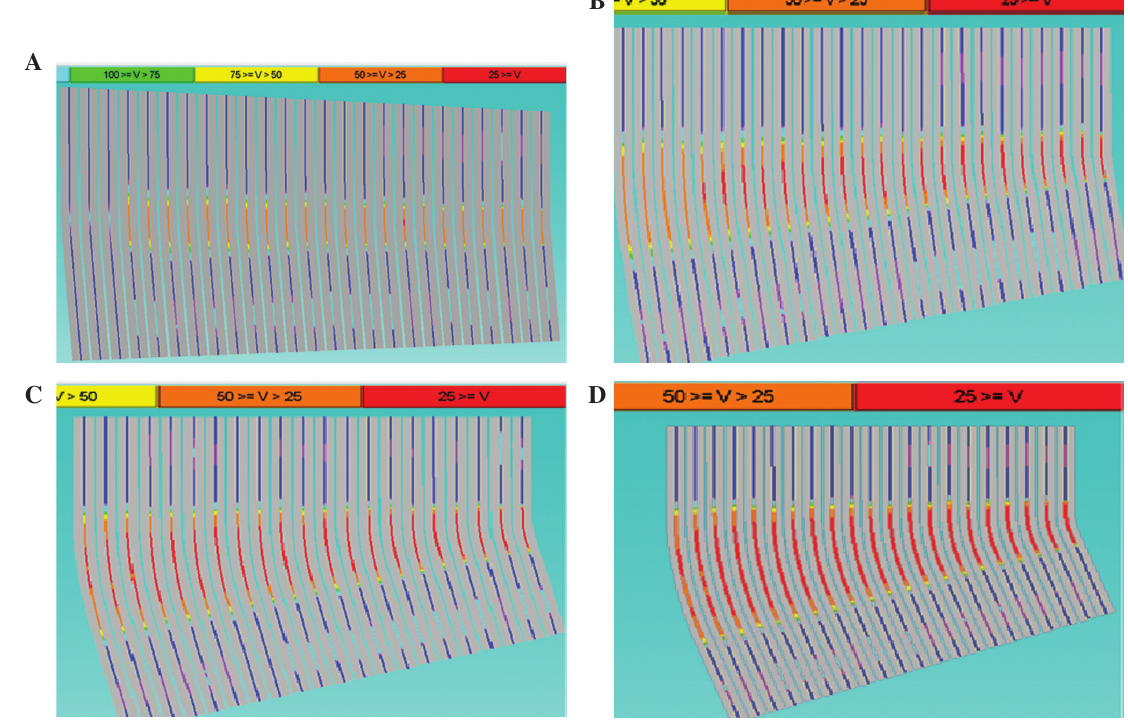
Figure 3 Simulation results of fiber steering trial 1: (A) case 1, θ = 5 ° ; (B) case 2, θ = 10 ° ; (C) case 3, θ = 15 ° ; (D) case 4, θ = 20 °